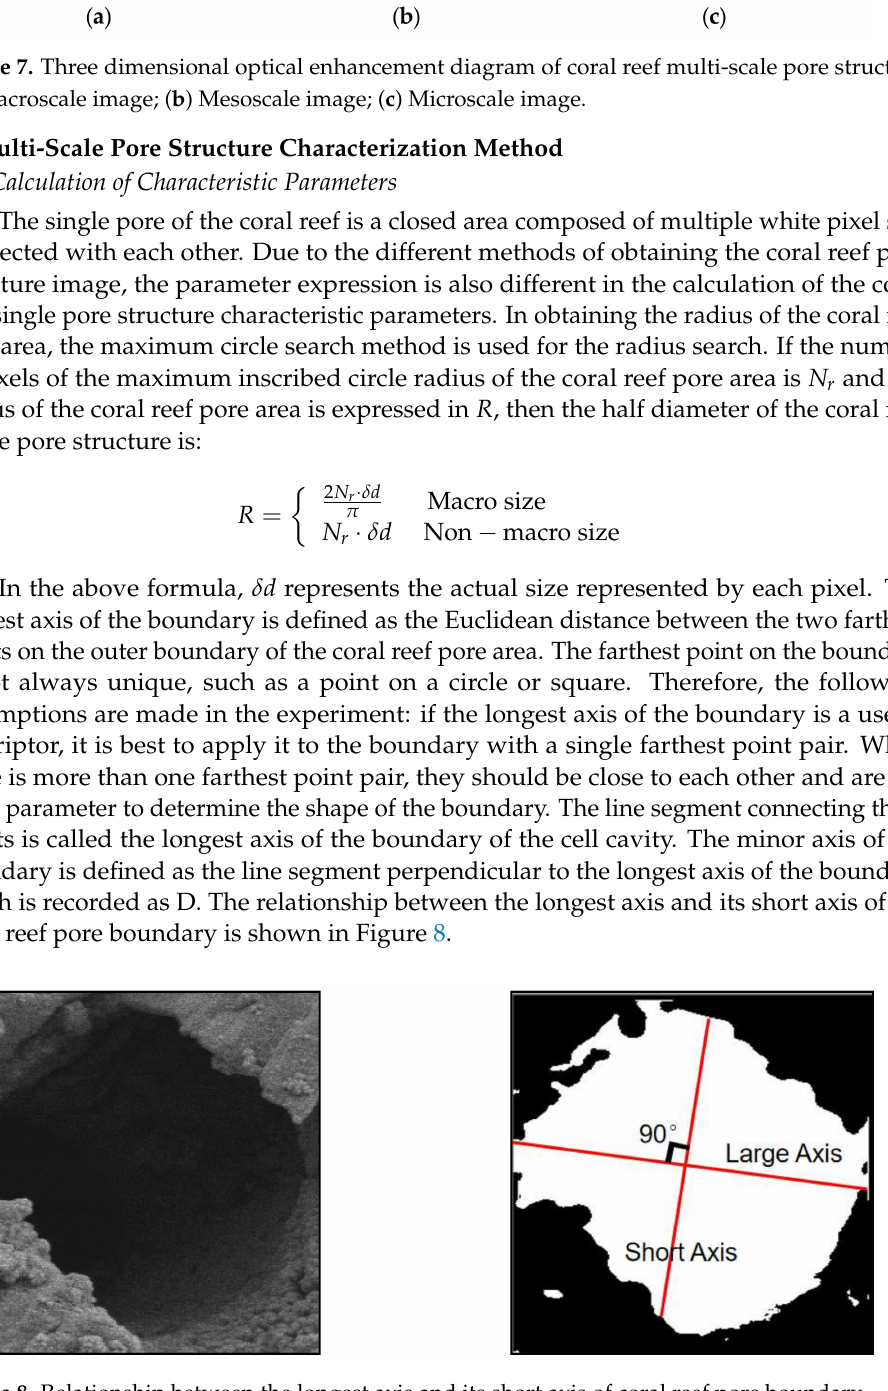
Figure 8. Relationship between the longest axis and its short axis of coral reef pore